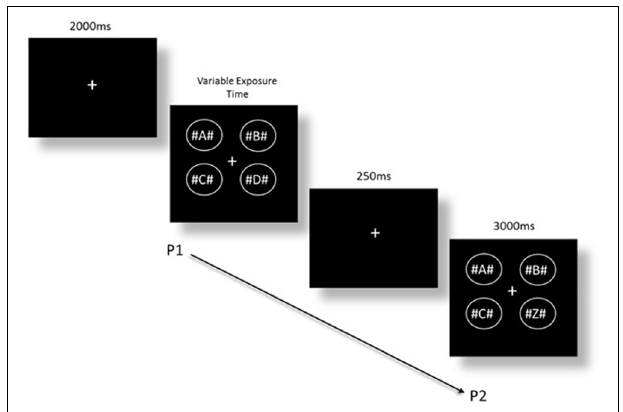
FIGURE 2 | Change detection (CD) task where a change has occurred from presentation 1 (P1) to presentation 2 (P2).